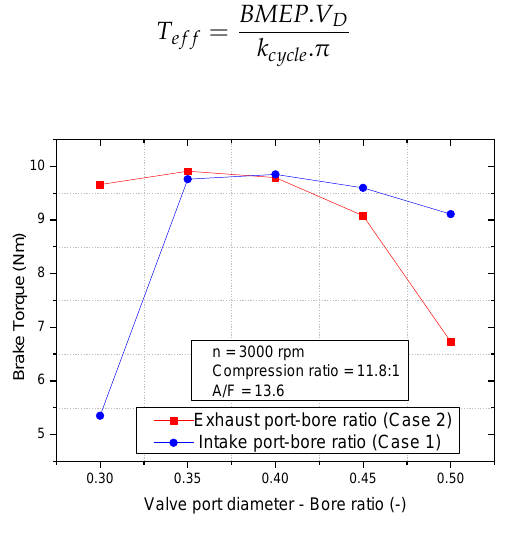
Figure 19. Brake torque versus VPD /